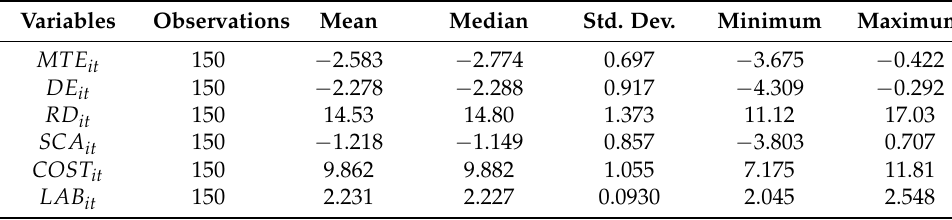
Table 6. Statistical description of the